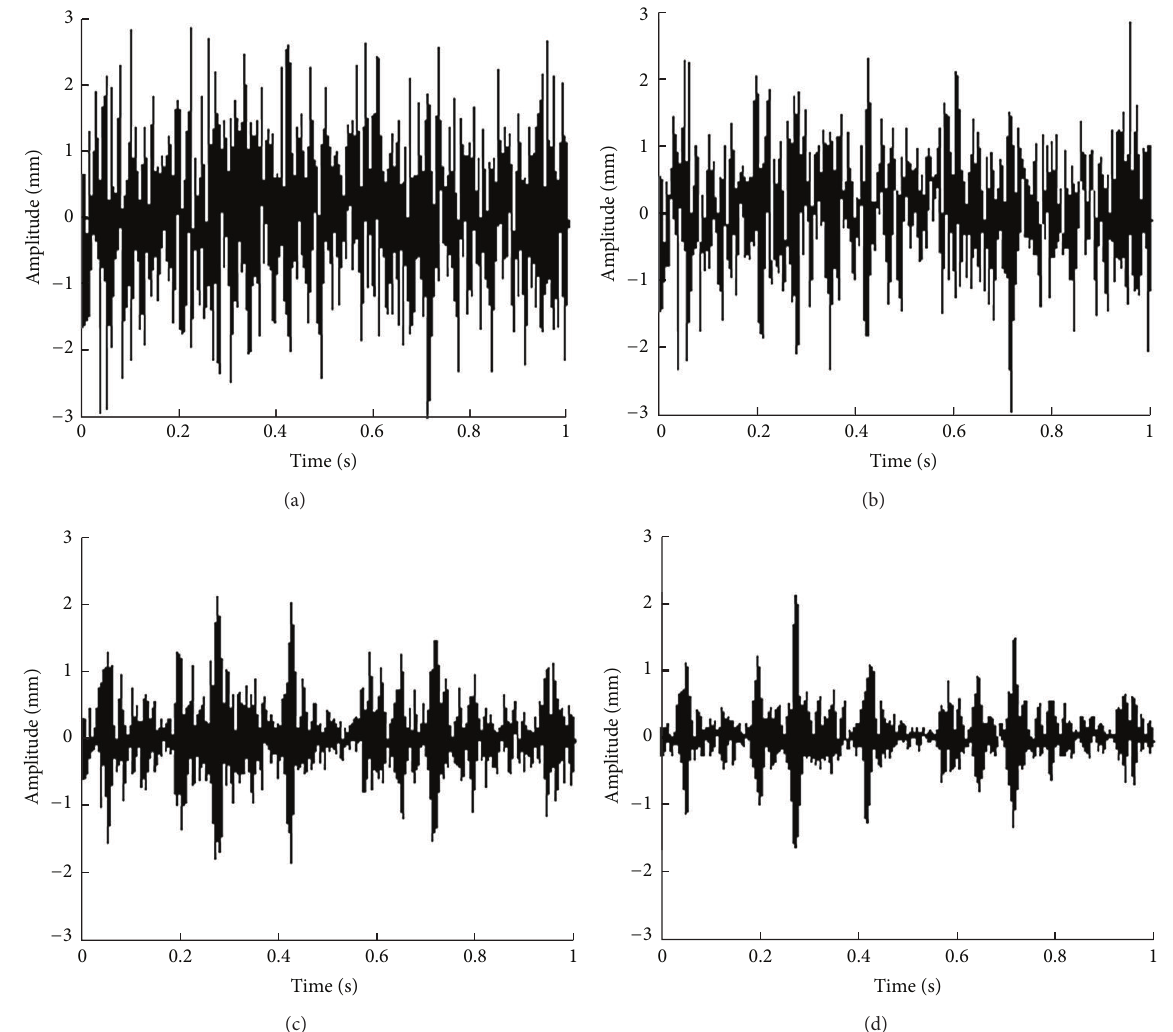
Figure 4: Comparison of denoising results obtained by the optimal filter (0, 0.01, 0), the morphological filter of flat SE (0, 0, 0), and the wavelet of Morlet (with 𝑤 0 set to 5, 𝑎 𝑗 equal to 𝑎 set to 0.3), for the vibration signal of a roller bearing with an inner-race fault: (a) the original signal, (b) the wavelet of Morlet, (c) the morphological filter of flat SE, and (d) the optimal filter.